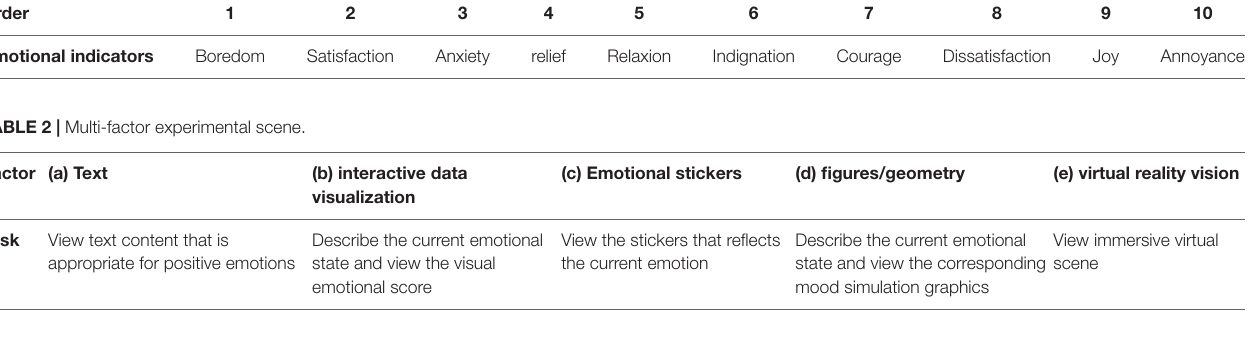
TABLE 3 | Statistical table of emotion value in singles factor experiment.